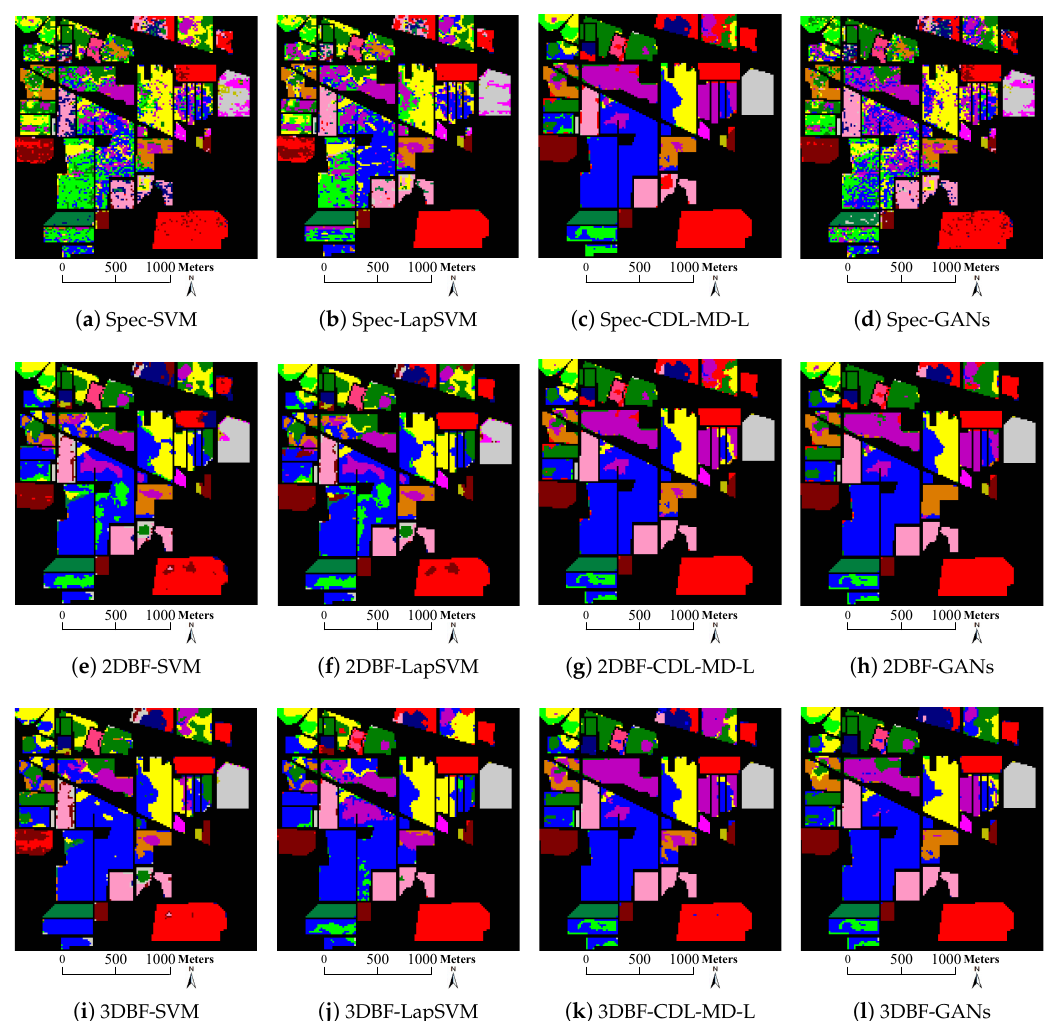
Figure 11. Classification maps of the Indian Pines data with 5 samples per